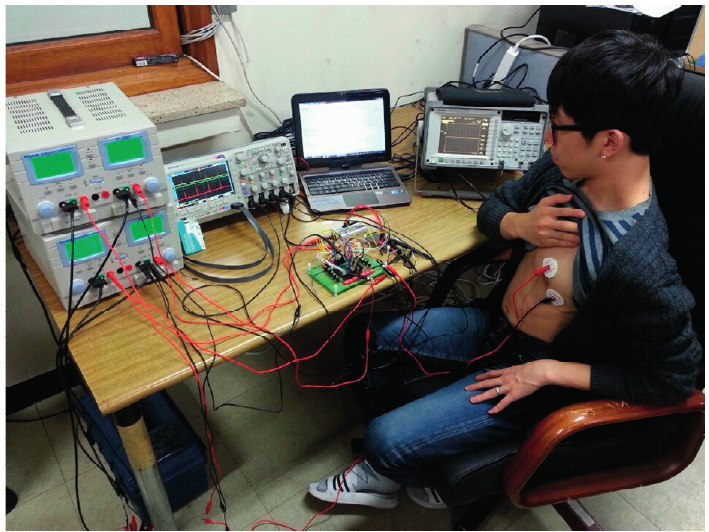
Figure 18. ECG signal measurement environment.